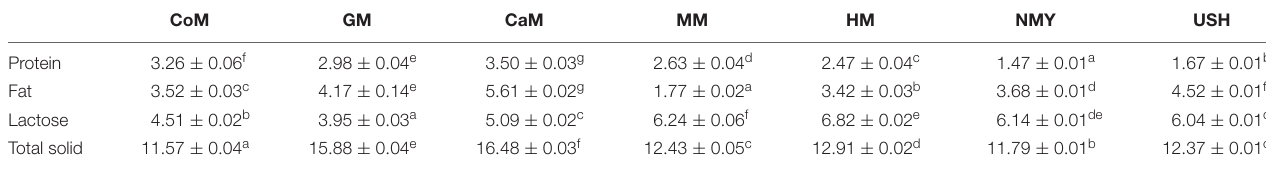
TABLE 1 | The content of the main component of different kinds of milk (%).